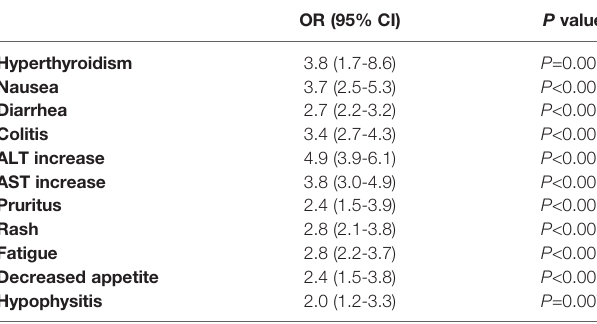
TABLE 3 | Comparison of grade ≥ 3 trAEs between cohort 1 and 2.